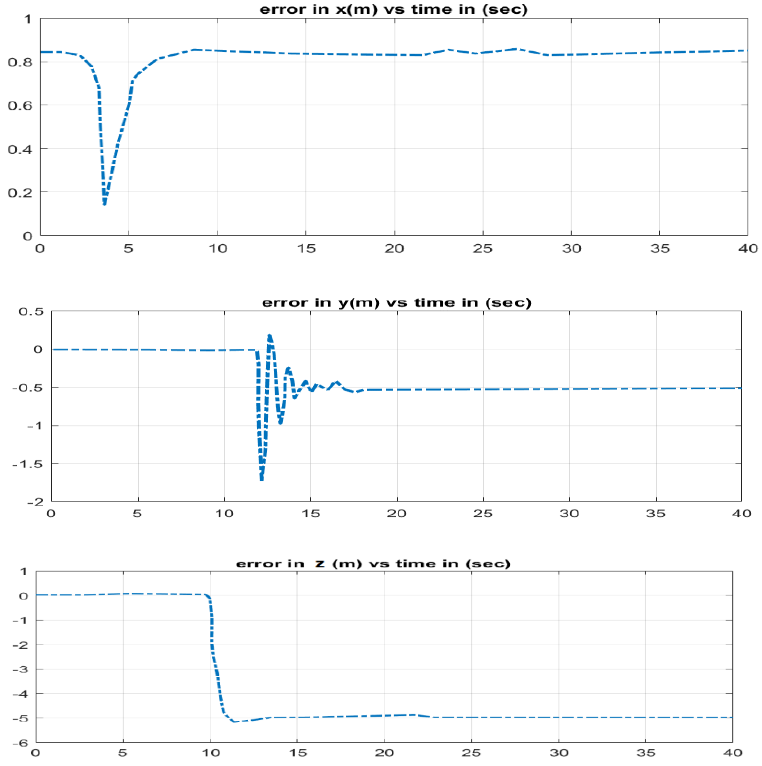
Figure 24. Position error rates while maneuvering using MFSDF-SMC during hardware implemen- tation.